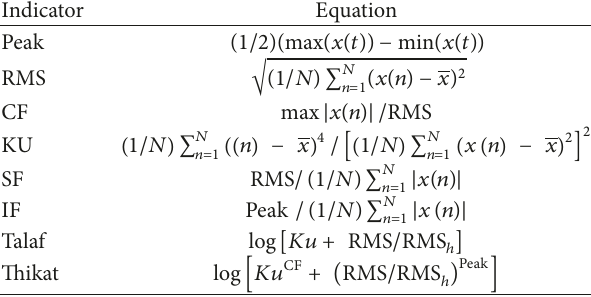
Table 5: Statistical time-domain fault diagnosis indicators [20].